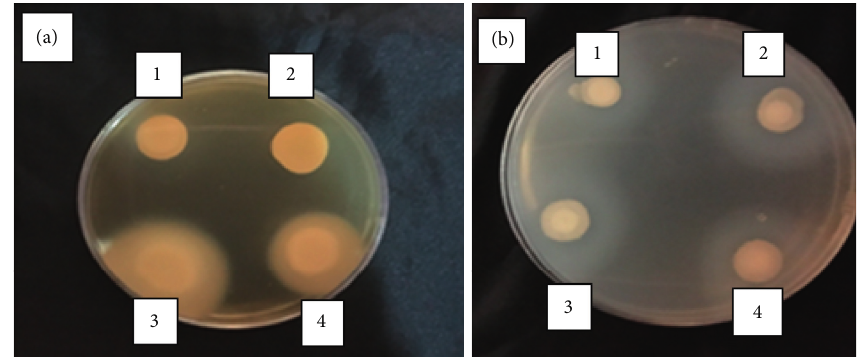
Figure 1: Phospholipase (a) and proteinase (b) activity. (a) Homozygous strain: spots 1, 3 (neg-pos); heterozygous strain: spots 2, 4 (neg- pos). (b) Homozygous and heterozygous strains: discs 1–4 (positive). Table 1: Comparison of virulence factors in heterozygous and homozygous strains of vaginal Candida albicans species. Virulence factors Strains Total Hemolysin (%) Phospholipase/Pzmean ( range ) Proteinase/Pzmean ( range ) α β c Homozygous 0.59 (0.38–1)